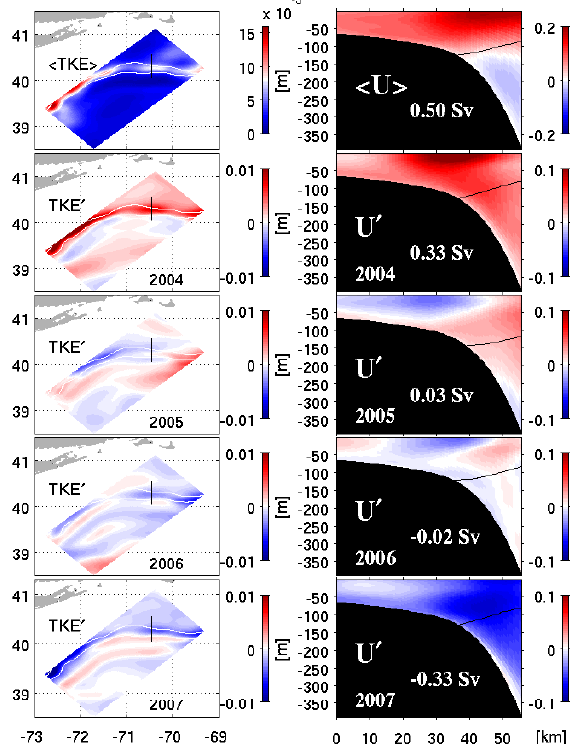
Fig. 12. Inter-annual variability of total kinetic energy (TKE: left Figure 12. Inter-annual variability of total kinetic energy (TKE: left column, in unit of 900 column, in unit of m 2 s − 2 ) and shelfbreak jet (right column, in unit m 2 /s 2 ) and shelfbreak jet (right column, in unit of m/s). The top two panels show the 901 of ms 1 ). The top two panels show the spring mean TKE and shelf- spring mean TKE and shelfbreak jet velocity (across the Nantucket transect; positive 902 break jet velocity (across the Nantucket transect; positive means means westward flow) averaged over 2004-2007. The following panels show the 903 westward flow) averaged over 2004–2007. The following panels anomaly fields of TKE and shelfbreak jet in springs 2004 through 2007 relative to 904 show the anomaly fields of TKE and shelfbreak jet in springs 2004 their respective 4-year means. Also shown in the left hand panels are 100 and 200 m 905 through 2007 relative to their respective 4-year means. Also shown isobaths (white curves) and location of Nantucket transect (black line).The mean 906 in the left hand panels are 100 and 200m isobaths (white curves) <u>and anomaly u’ alongshelf transport values are given in the right-hand panels. 907 and location of Nantucket transect (black line).The mean < u > and anomaly u’ alongshelf transport values are given in the right-hand